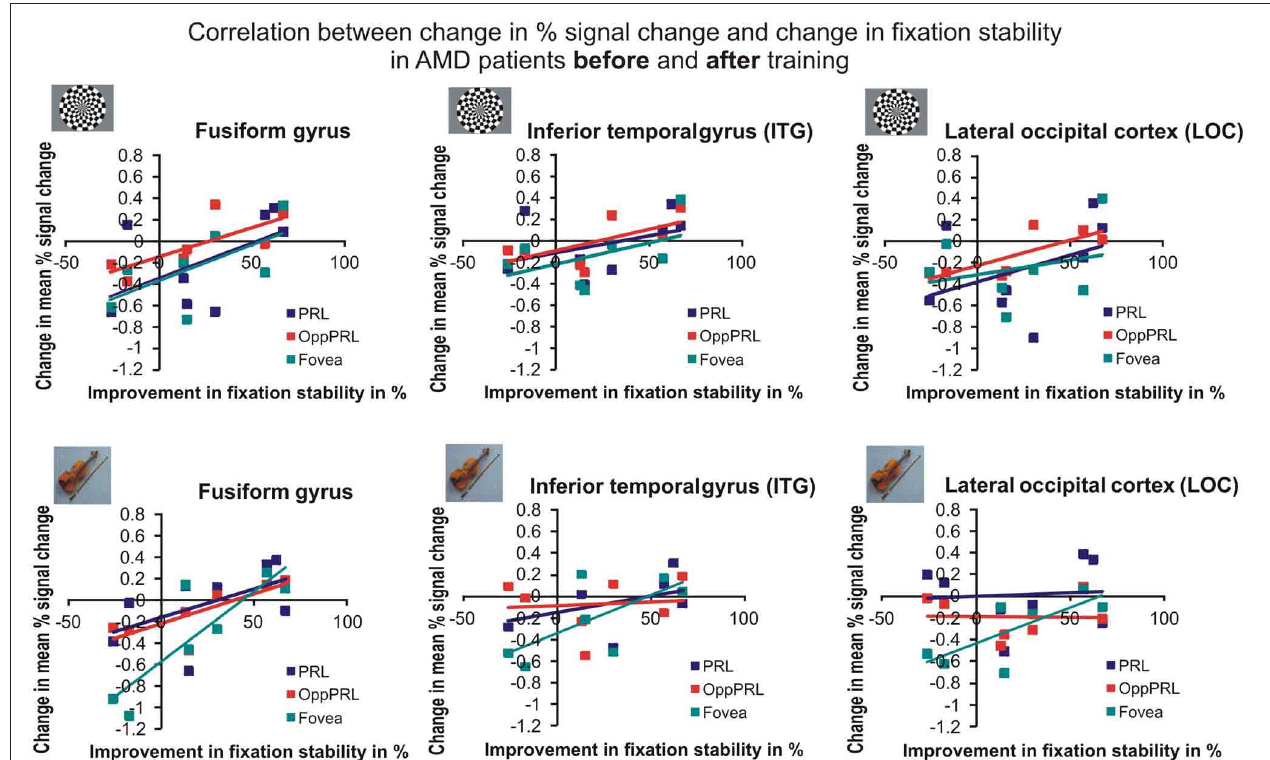
changes in % signal change and changes in fixation stability in case of checkerboard stimulation, the lower row depicts these correlations for everyday images. As in Figures 8 , 9 , the differently colored symbols refer to the different retinal locations that were stimulated (green, fovea; red, OppPRL; blue,